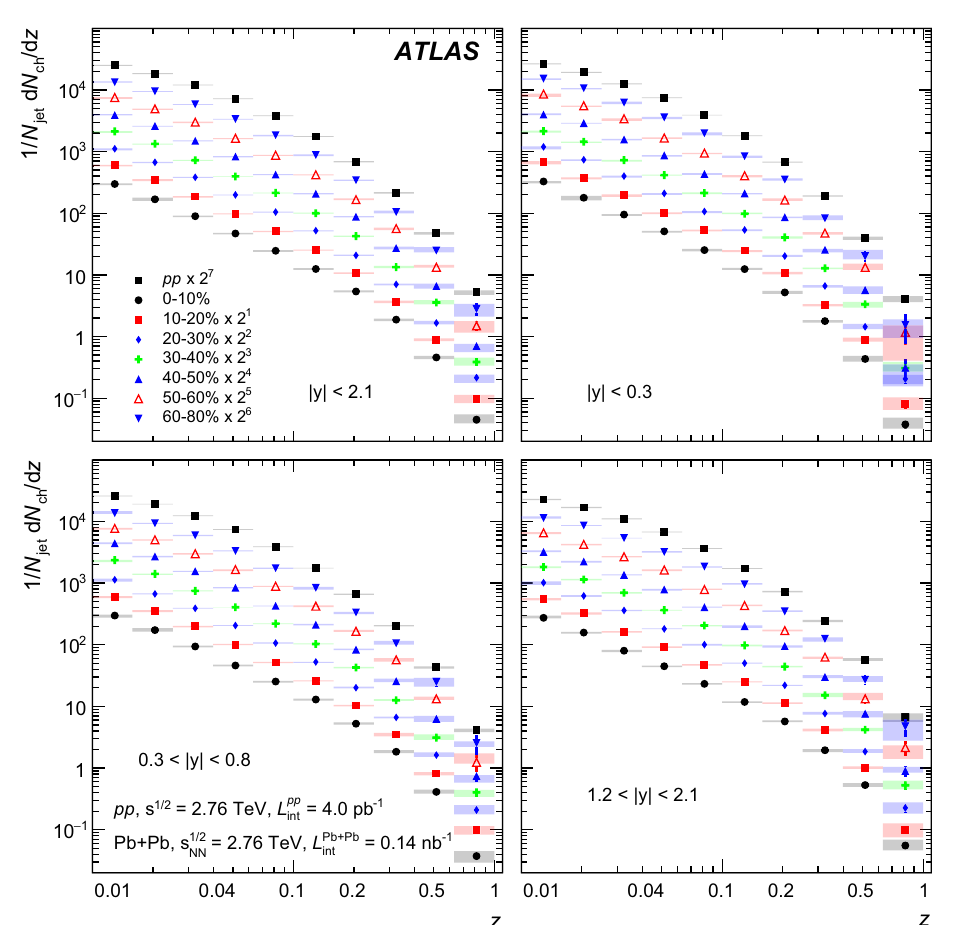
Fig. 3 Unfolded distributions of longitudinal momentum fraction, D ( z ) , measured in pp collisions and for seven centrality bins mea- sured in Pb+Pb collisions. The four panels show D ( z ) distributions